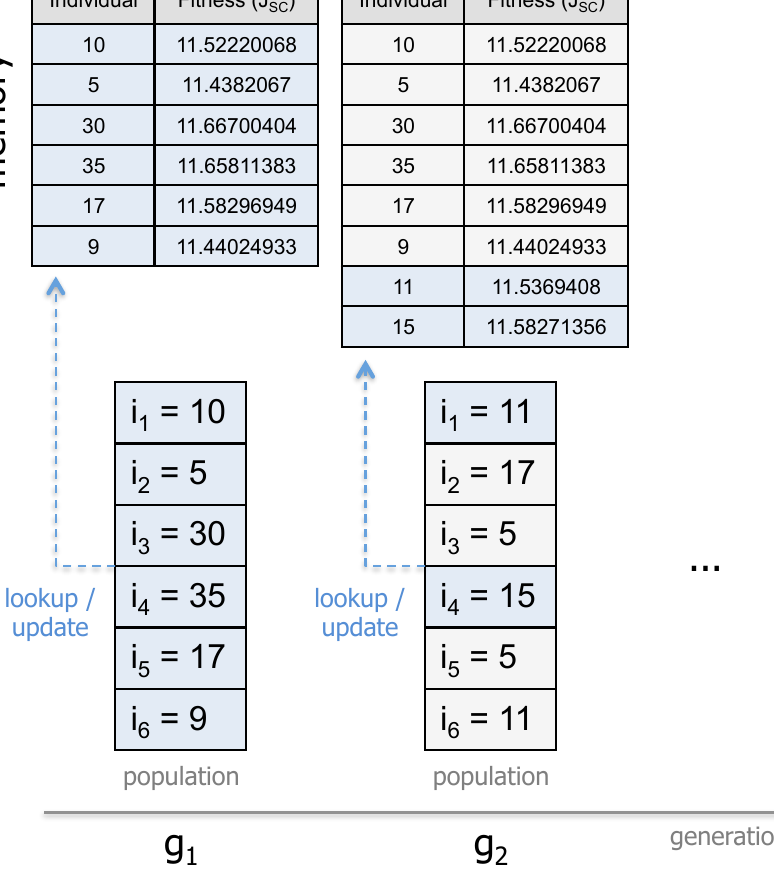
Figure 6. Genetic algorithm with dynamic programming, where blue represents values that need to be added to the lookup table in order to update it and grey represents values that have already been evaluated and need only to be copied when